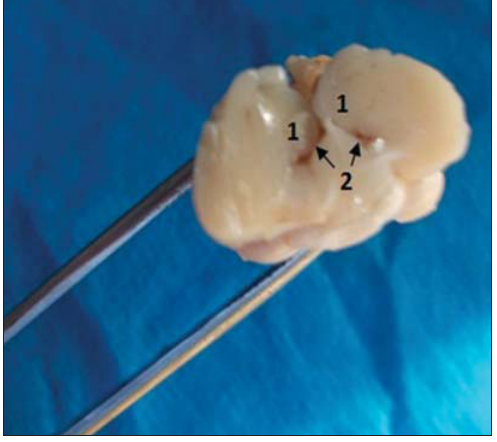
Figure-3: Transverse section of brain. (1) Hippocampus, (2) Lateral Ventricle.